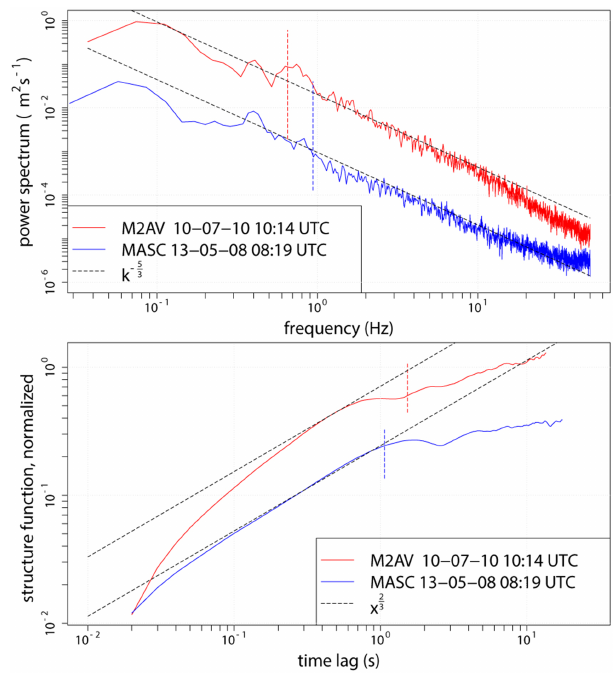
Fig. 17. A variance spectrum and a structure function of true air- speed measured with the MASC RPA in comparison to a measure- ment with the M 2 AV RPA. In both plots, the result is an average over 15 legs of 27s each. The structure function is normalized by 2 σ 2 and therefore dimensionless. In both plots, MASC results are shifted towards lower values for better readability. The dashed lines indicate an estimation of the entry point of the inertial subrange. See text for flight